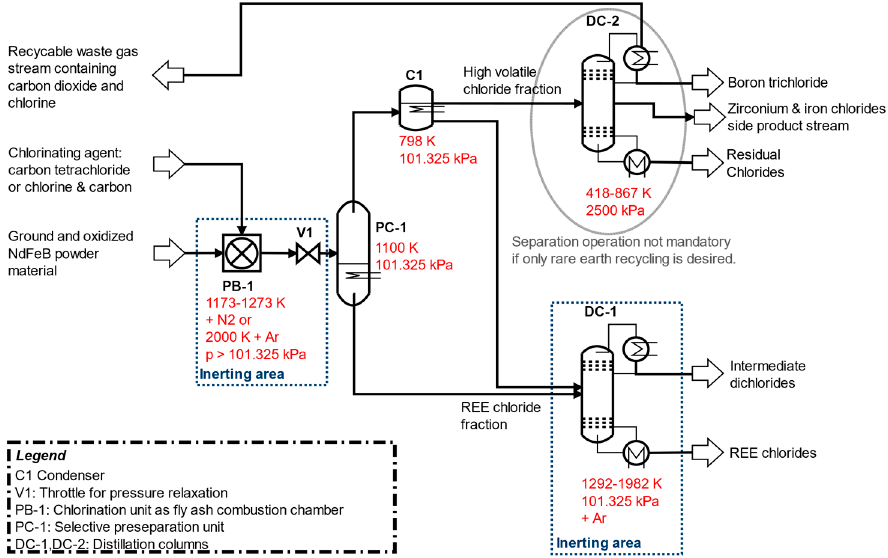
Figure 1. Recommended separation process for distillation-based recovery of REEs and other raw materials (including boron and zirconium recovery in DC-2) from ground NdFeB magnet material. (1 atm = 101.325 kPa).